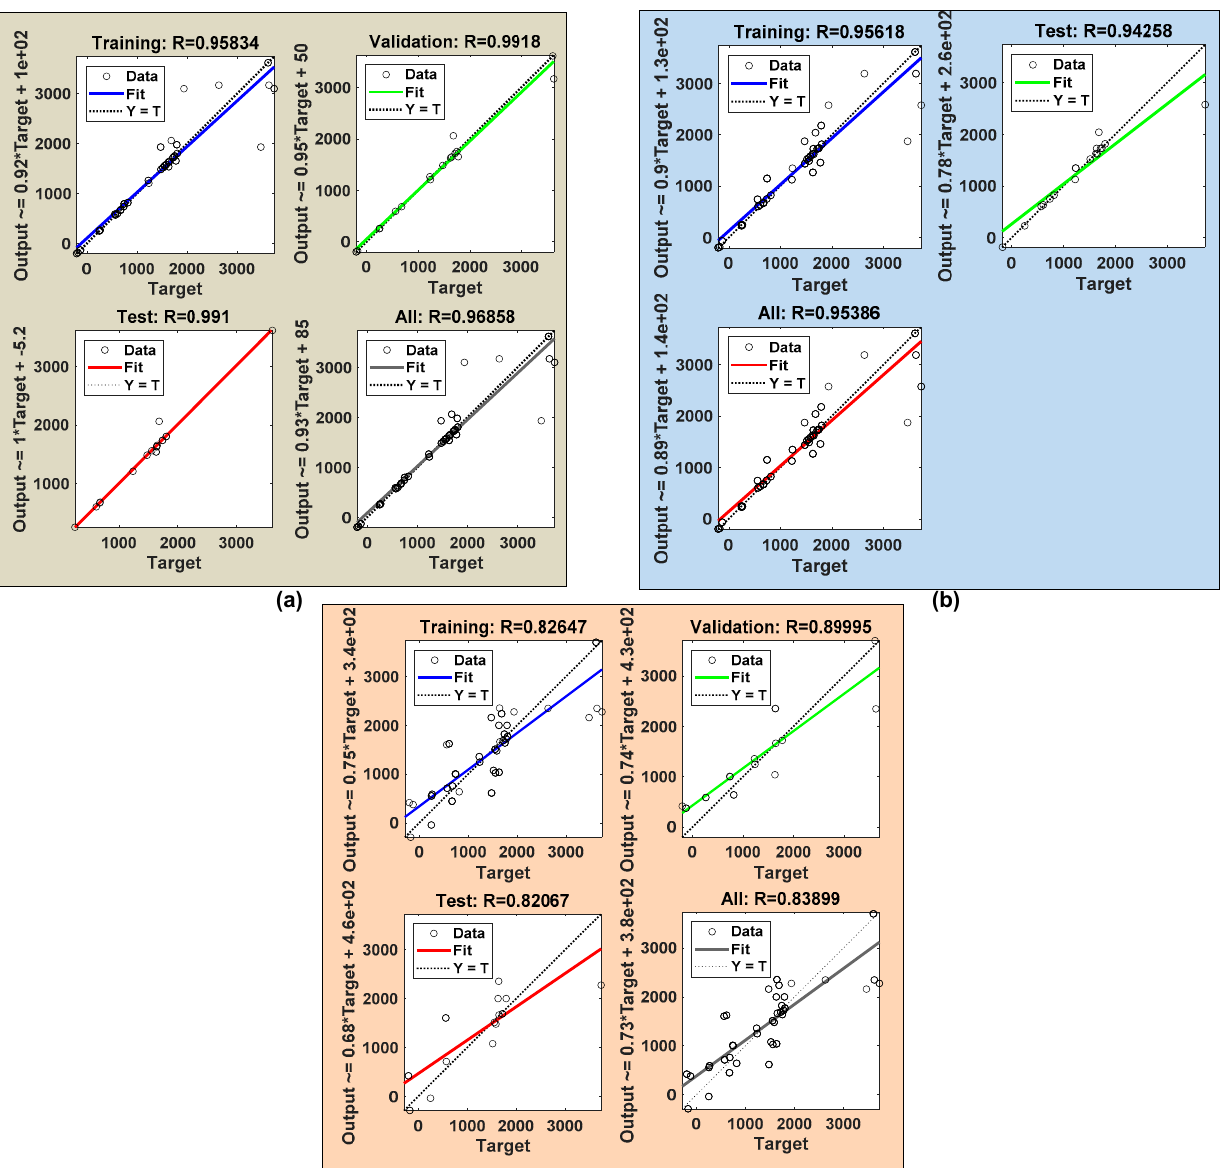
Figure 15. Regression plots of ANN with ( a ) Levenberg–Marquardt (LM) algorithm, ( b ) Bayesian Regulation (BR) algorithm, and ( c ) Scaled Conjugate Gradient (SCG) algorithm.